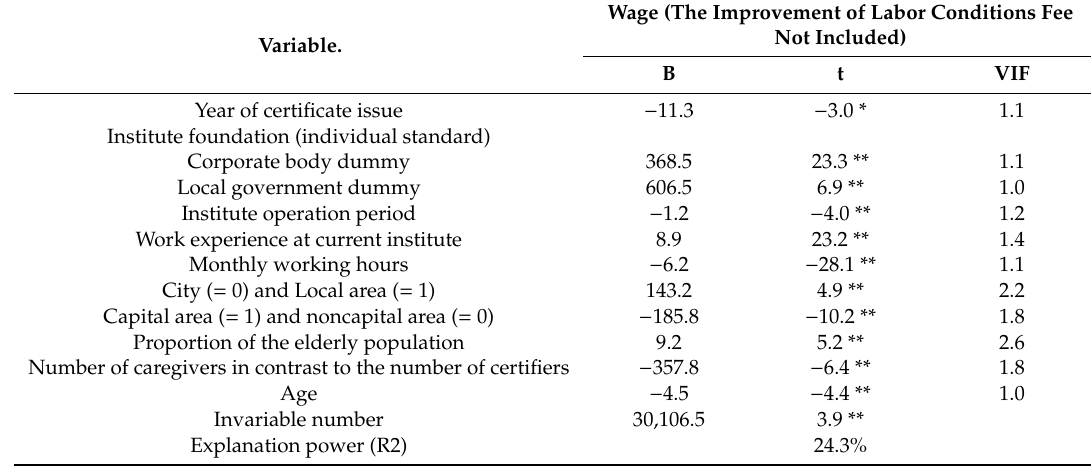
Table 7. The factors a ff ecting the wage of care workers working at home care facilities. Wage (The Improvement of Labor Conditions Fee Not Variable.